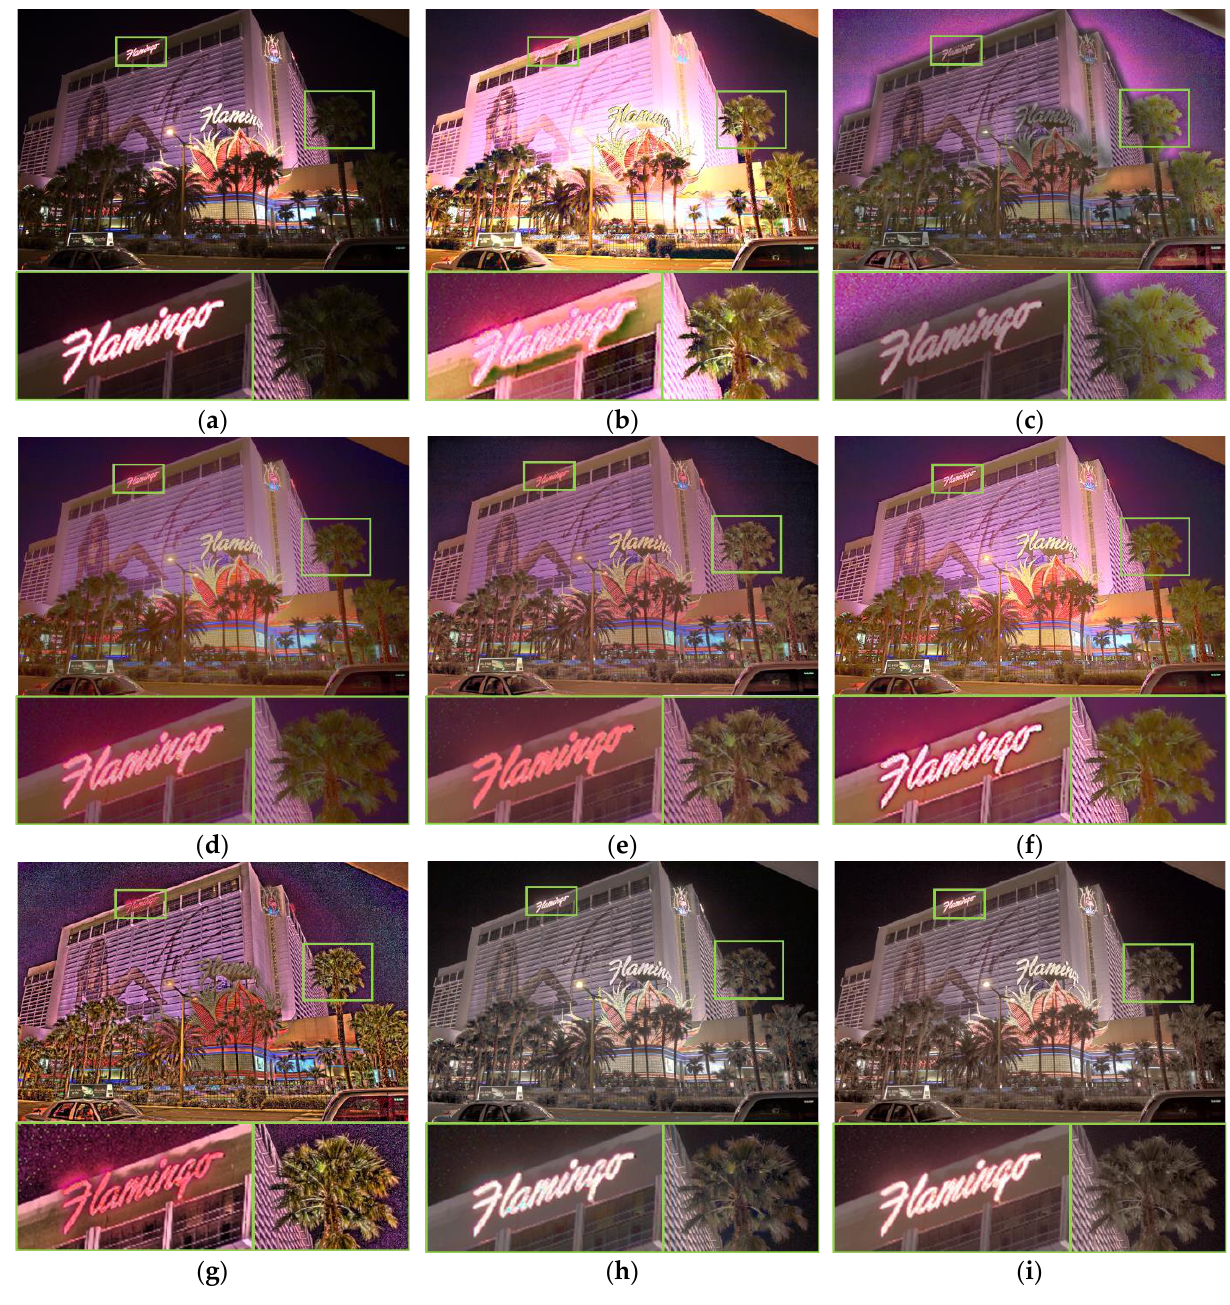
Figure 10. Rendering results of each method for HDR scene #3; ( a ) input image with Gamma tone mapping for visualization; ( b ) Banterle; ( c ) Bruce; ( d ) Reinhard; ( e ) Liang; ( f ) Li; ( g ) Shibata; ( h ) iCAM06; ( i ) proposed method.